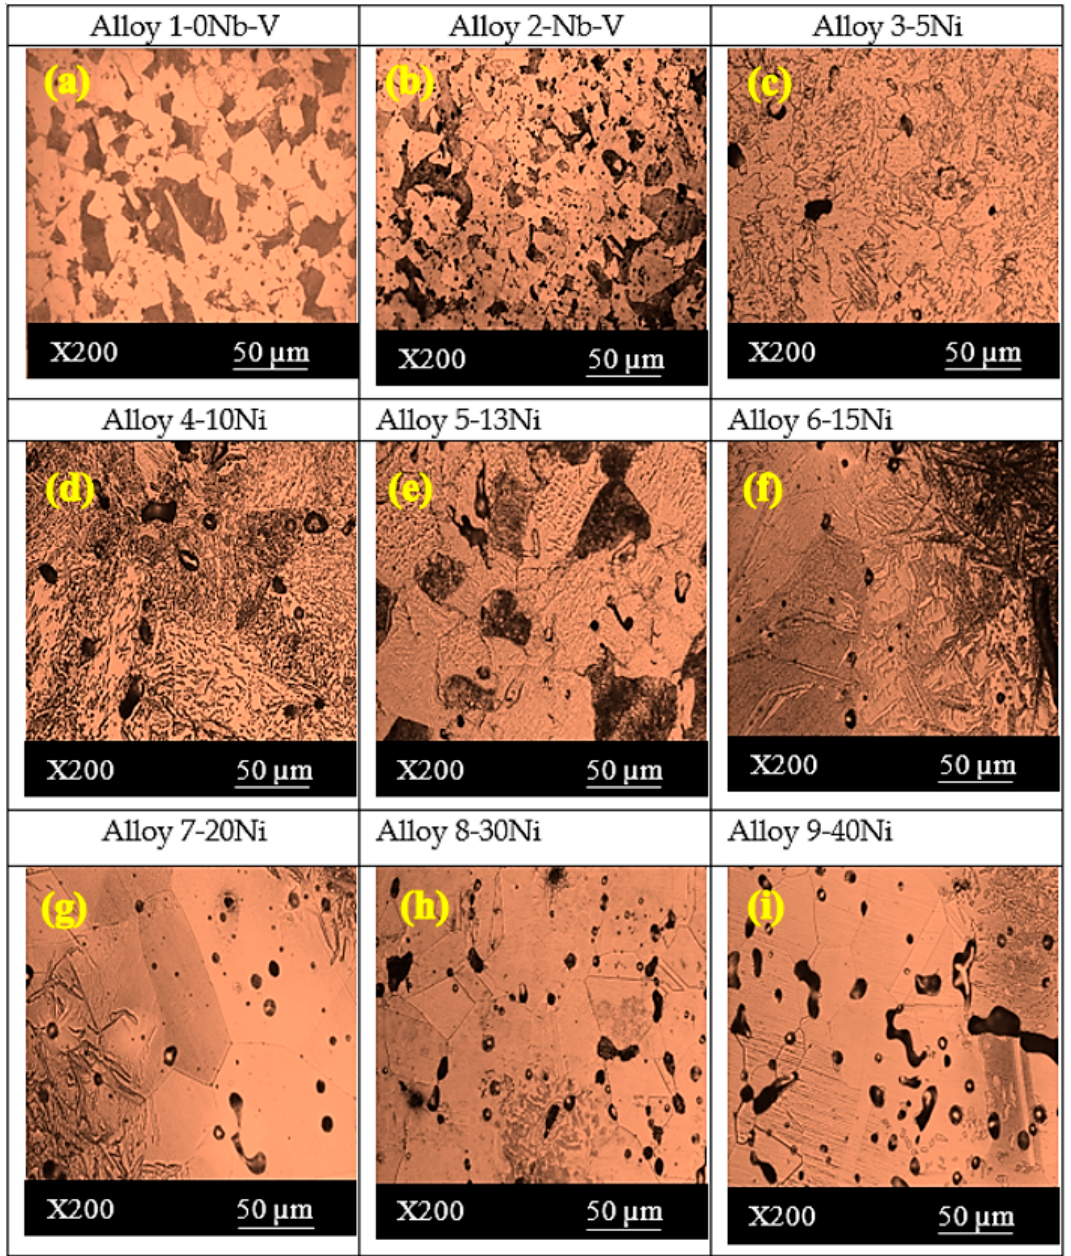
Figure 2. The optical micrographs of the alloys ( a ) without Nb–V, ( b ) without Ni, ( c ) 5.0 wt.% Ni, ( d ) 10 wt.% Ni, ( e ) 13 wt.% Ni, ( f ) 15 wt.% Ni, ( g ) 20 wt.% Ni, ( h ) 30 wt.% Ni, ( i ) 40 wt.%